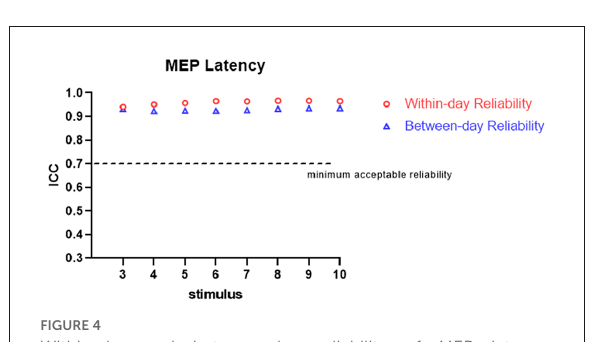
FIGURE4 Within-day and between-day reliability of MEP latency. ICC, intraclass